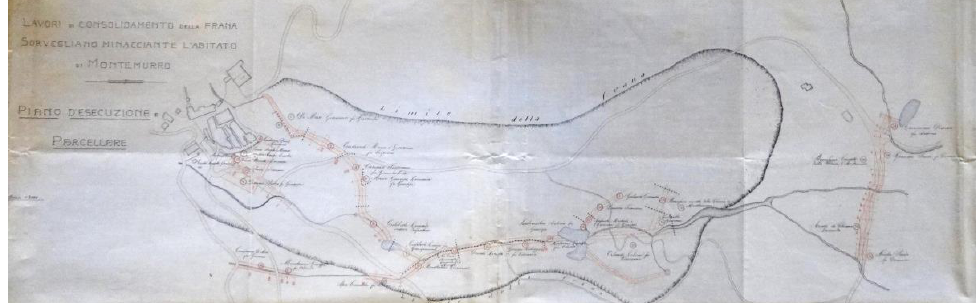
Figure 15. Map of the Servigliano landslide, as portrayed in the Piano d’esecuzione e parcellare (work plan and cadastral parcel plan for expropriation) in November 1916. The map displays the planimetric extension of the landslide in which both the landslide lakes (in blue) and drainage and consolidation works (in yellow) are reported. 6 The landslide boundary (“limite della frana” on the map) was imposed over the current landslide map of the area (Figure 7). Original drawing to scale 1:2,000.